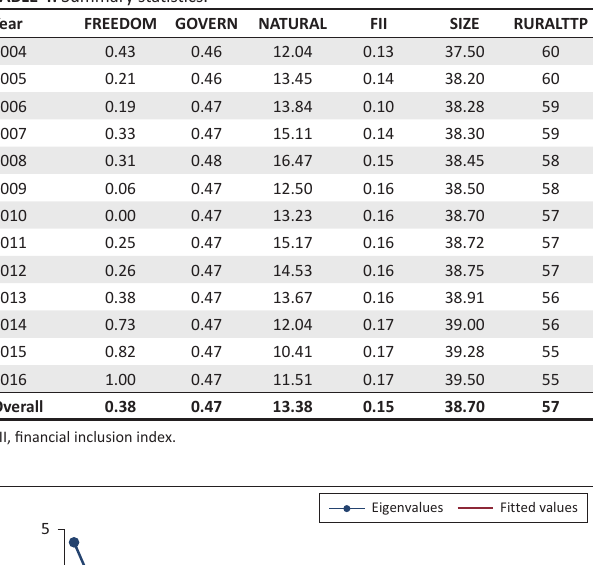
TABLE 4: Summary statistics.